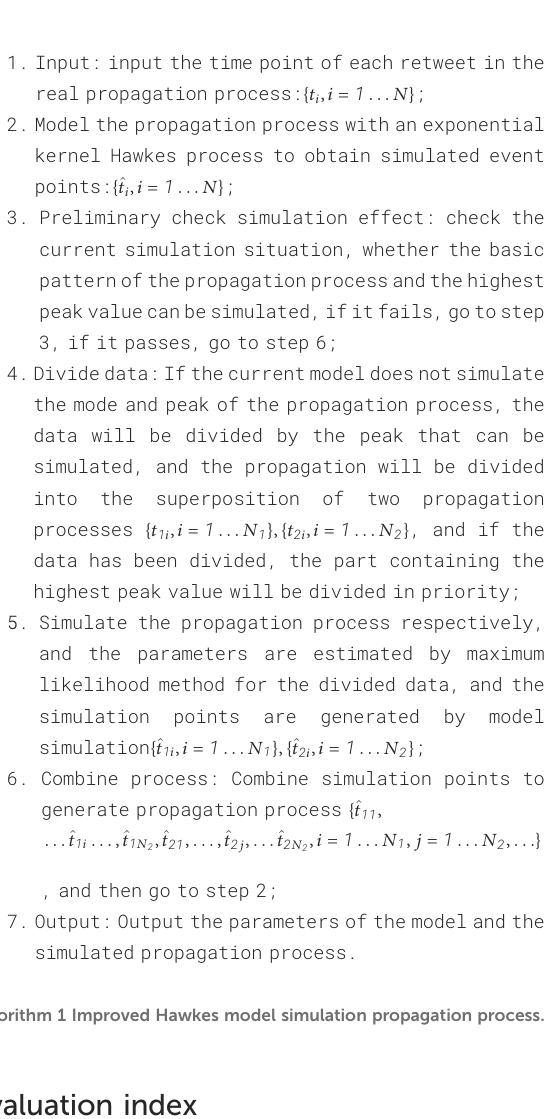
Algorithm 1 Improved Hawkes model simulation propagation process.